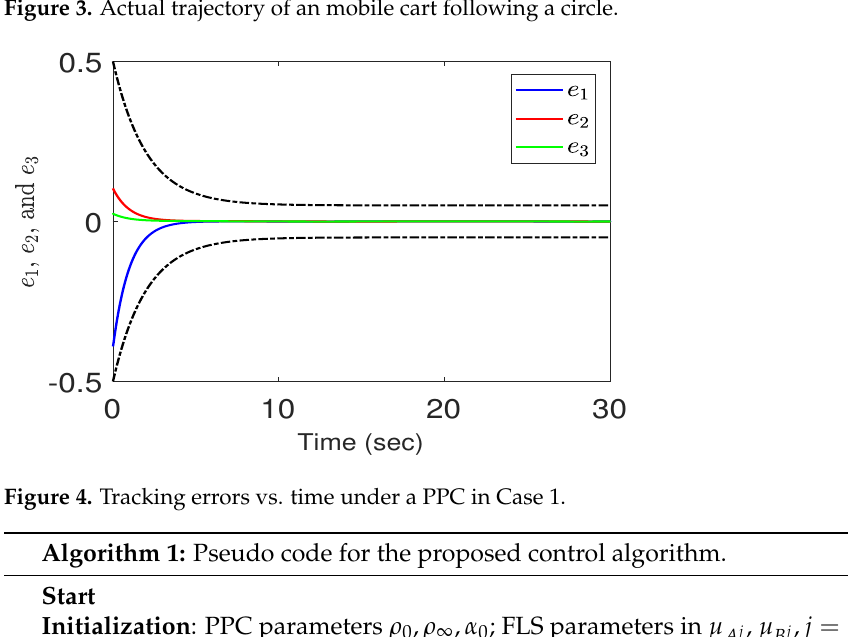
Figure 3. Actual trajectory of an mobile cart following a circle.